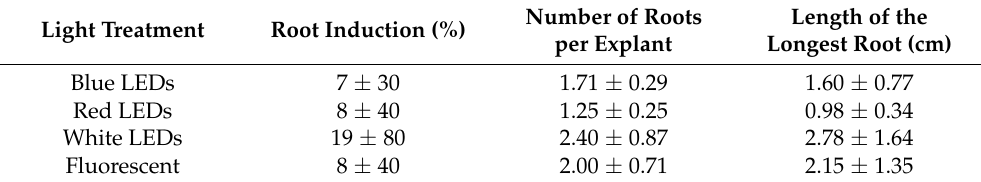
Table 1. Root induction (%), number of roots per explant, and length of the longest root of Pinus ponderosa shoots cultured in half LP macronutrients according to light treatment (blue LEDs, red LEDs, white LEDs, and fluorescent light). Data are presented as mean values ± S.E. Light Treatment